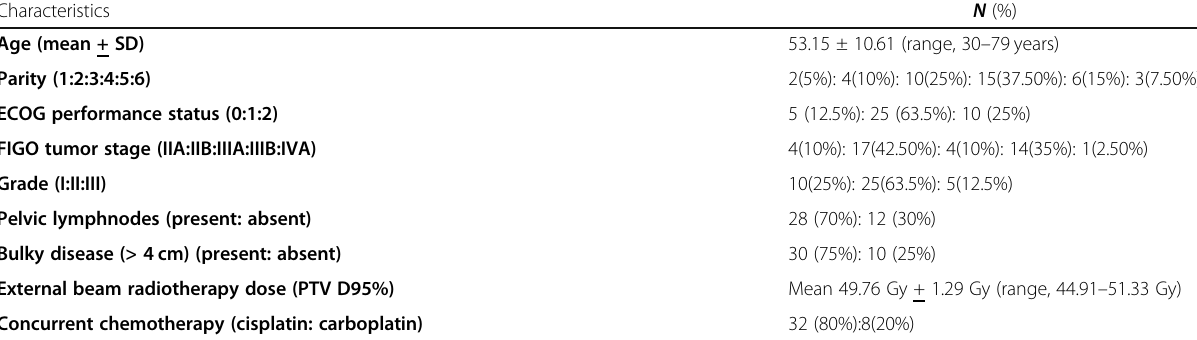
Table 1 Patient and treatment characteristics of patients enrolled in the present study